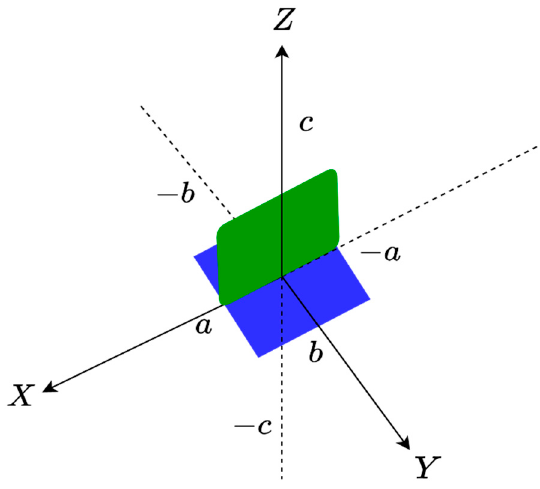
Figure 7. The geometry of the XY and XZ faces for an L-shaped ID.